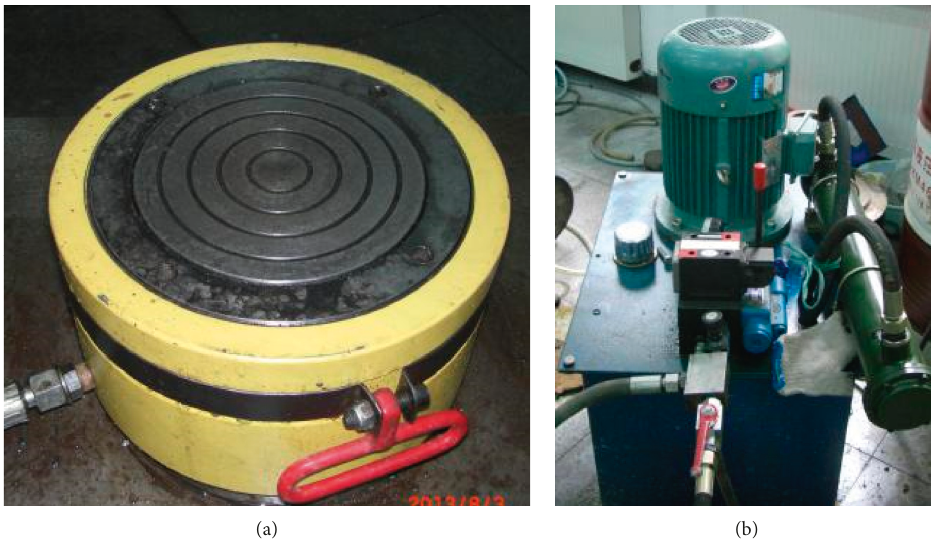
Figure 3: The (a) single-action hydraulic cylinder and (b) variable displacement piston